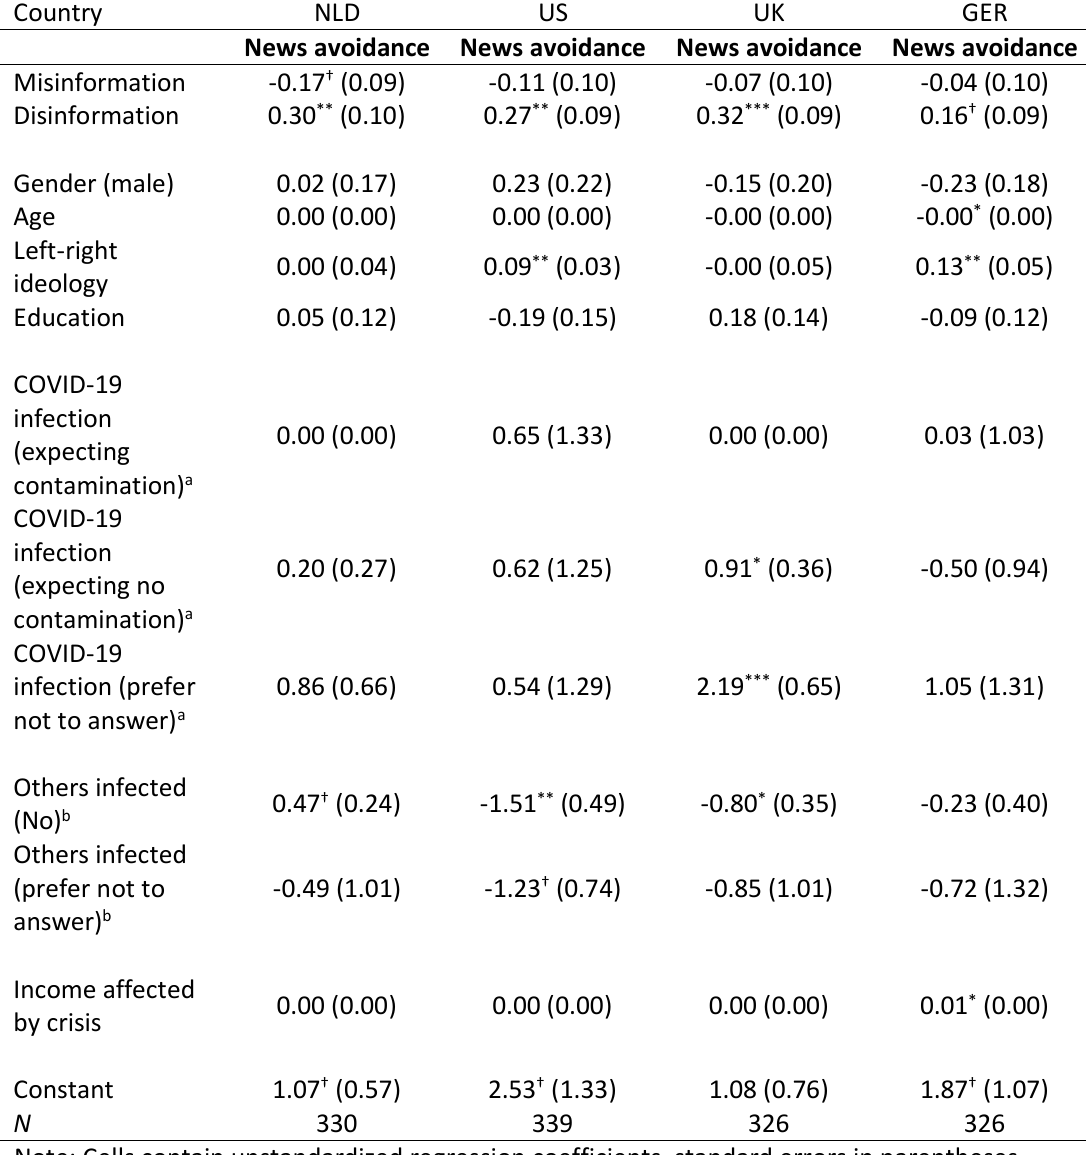
Table B2 . News avoidances predicted by levels of perceived mis- and disinformation, specified per